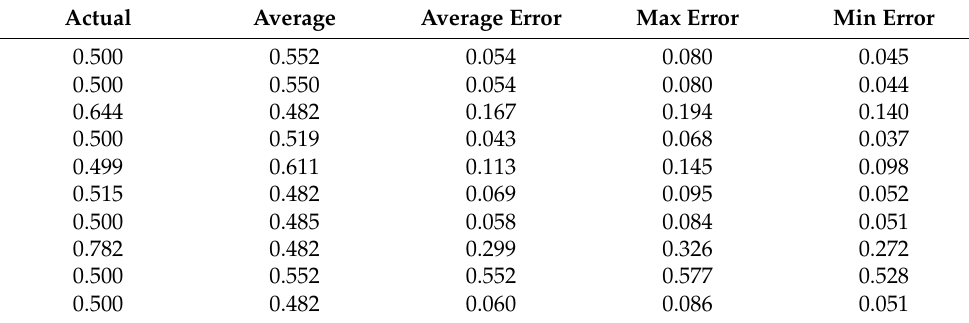
Table A80. Set 2, trials 1–10 data (actual PR value).